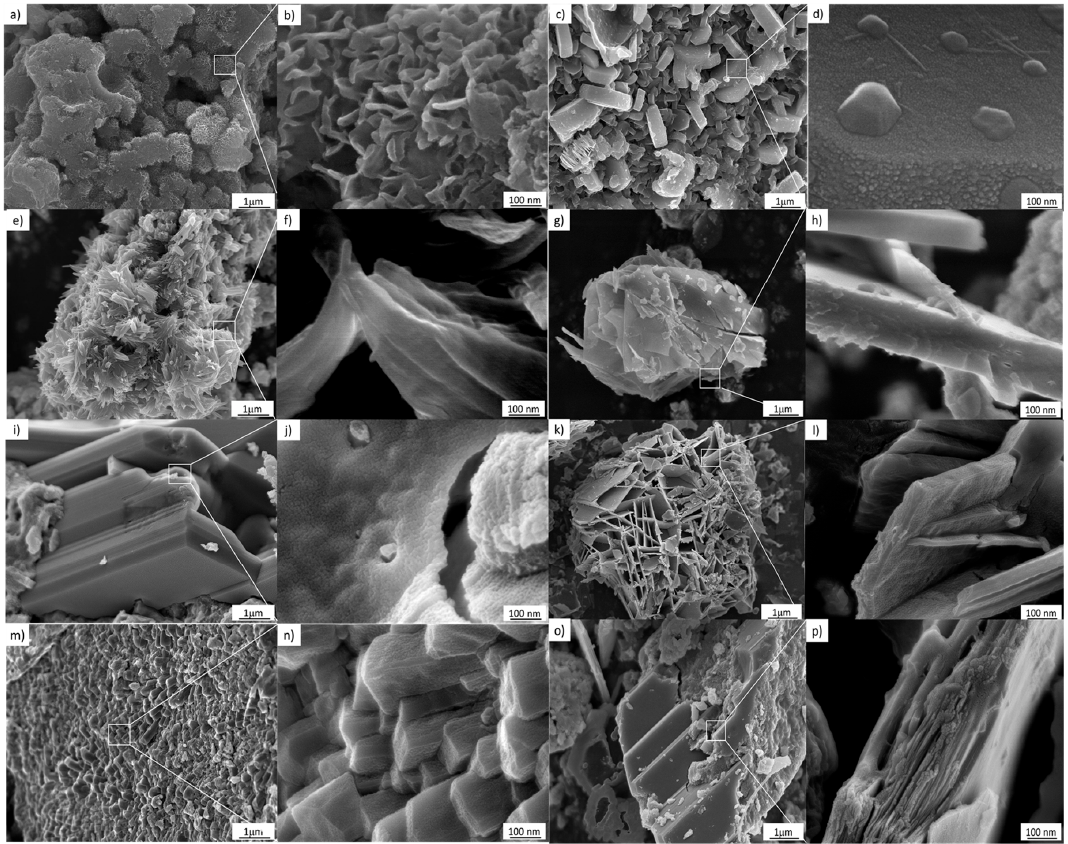
Figure 6. FESEM images of the samples treated hydrothermally at 110 °C for 24 h. ( a ) and ( b ) 3 M, ( c ) and ( d ) 4 M, ( e ) and ( f ) 5 M, ( g ) and ( h ) 6 M, ( i ) and ( j ) 7 M, ( k ) and ( l ) 8 M, ( m ) and ( n ) 9 M, ( o ) and ( p ) 10 M.